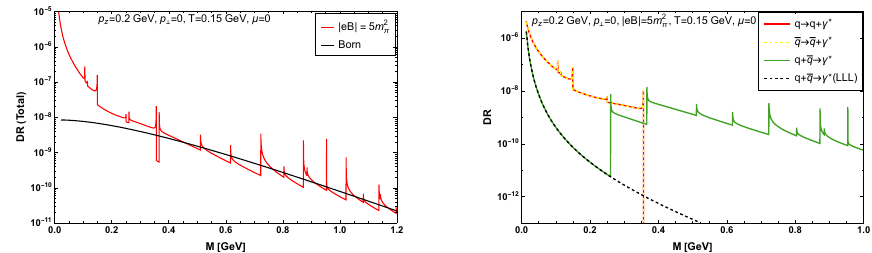
Figure 3. In the left panel we have the plot of DR as a function of invariant mass for eB = 5 m 2 π and compared with the Born rate. In the right panel the contribution coming from di ff erent processes are shown separately along with the LLL approximated rate [5].